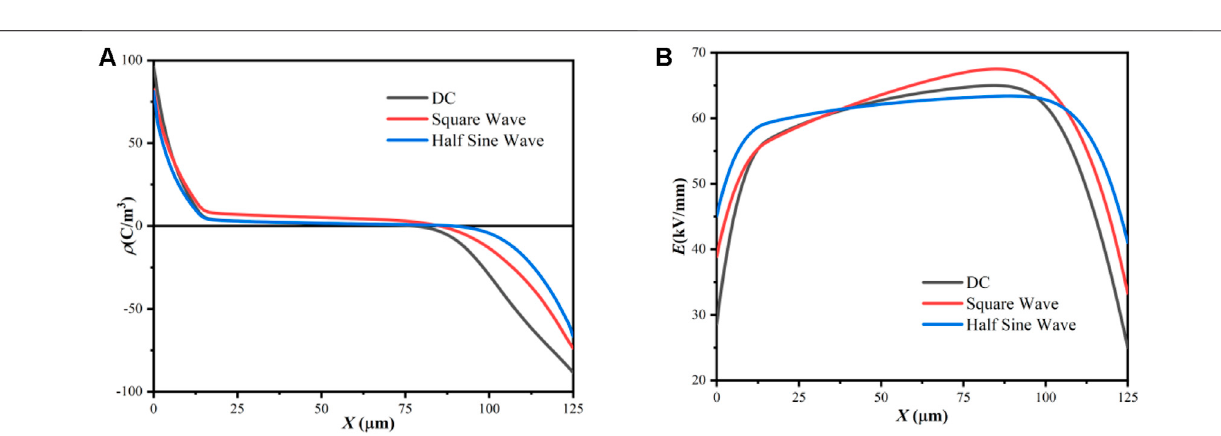
Frontiers in Materials |